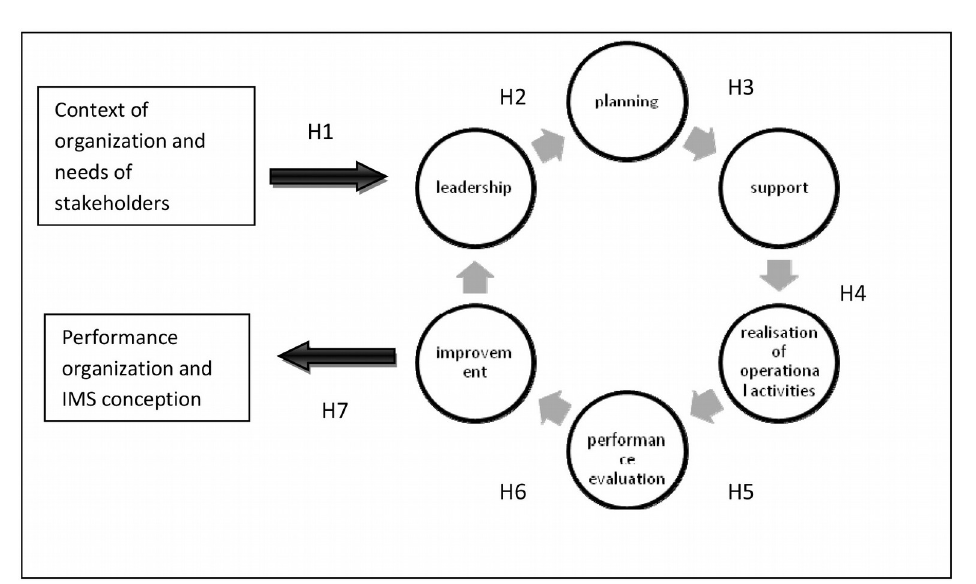
Figure 1. Proposed integrated management system (IMS)